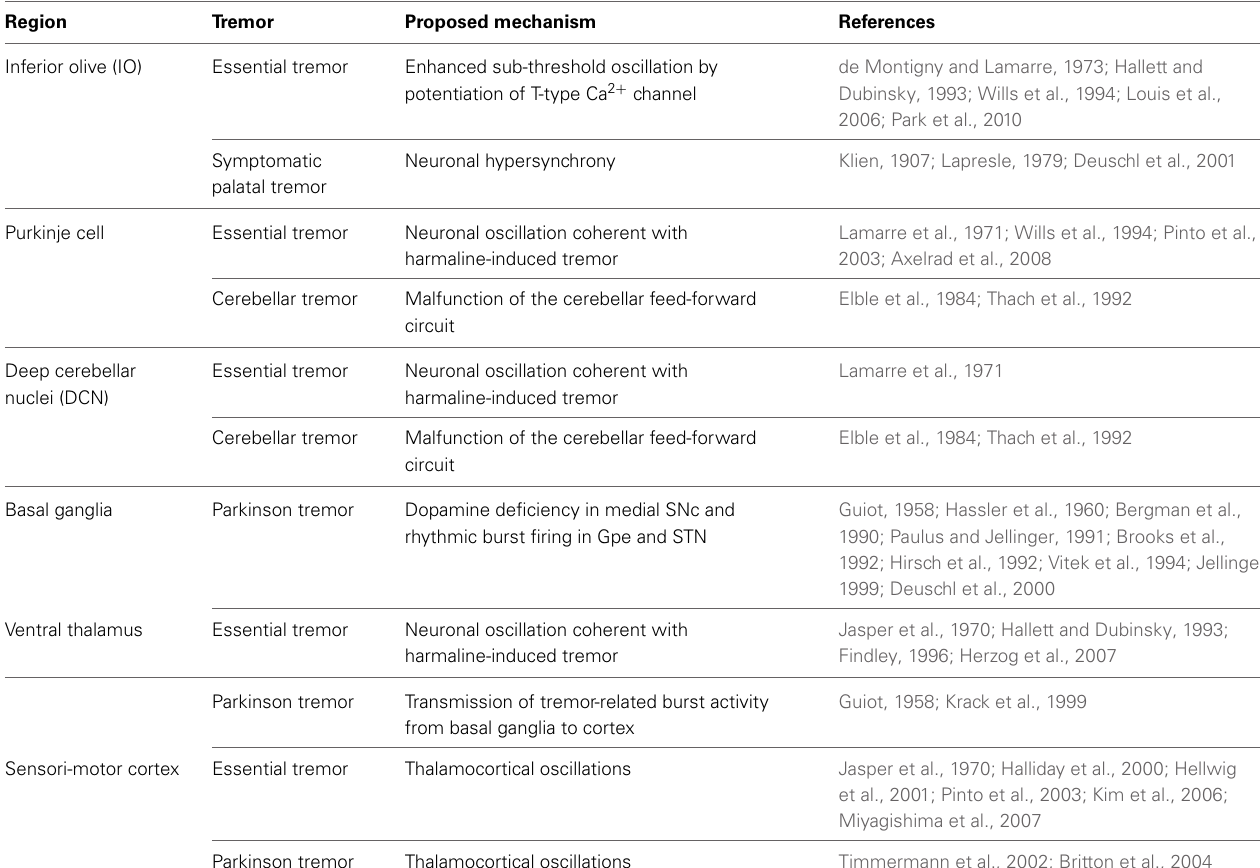
Table 1 | Mechanisms of pathological tremor.